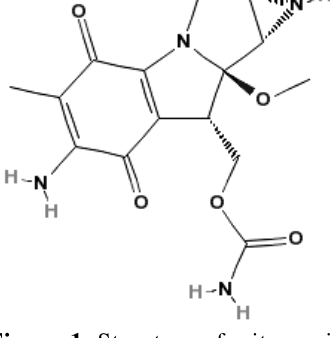
Figure 1. Structure of